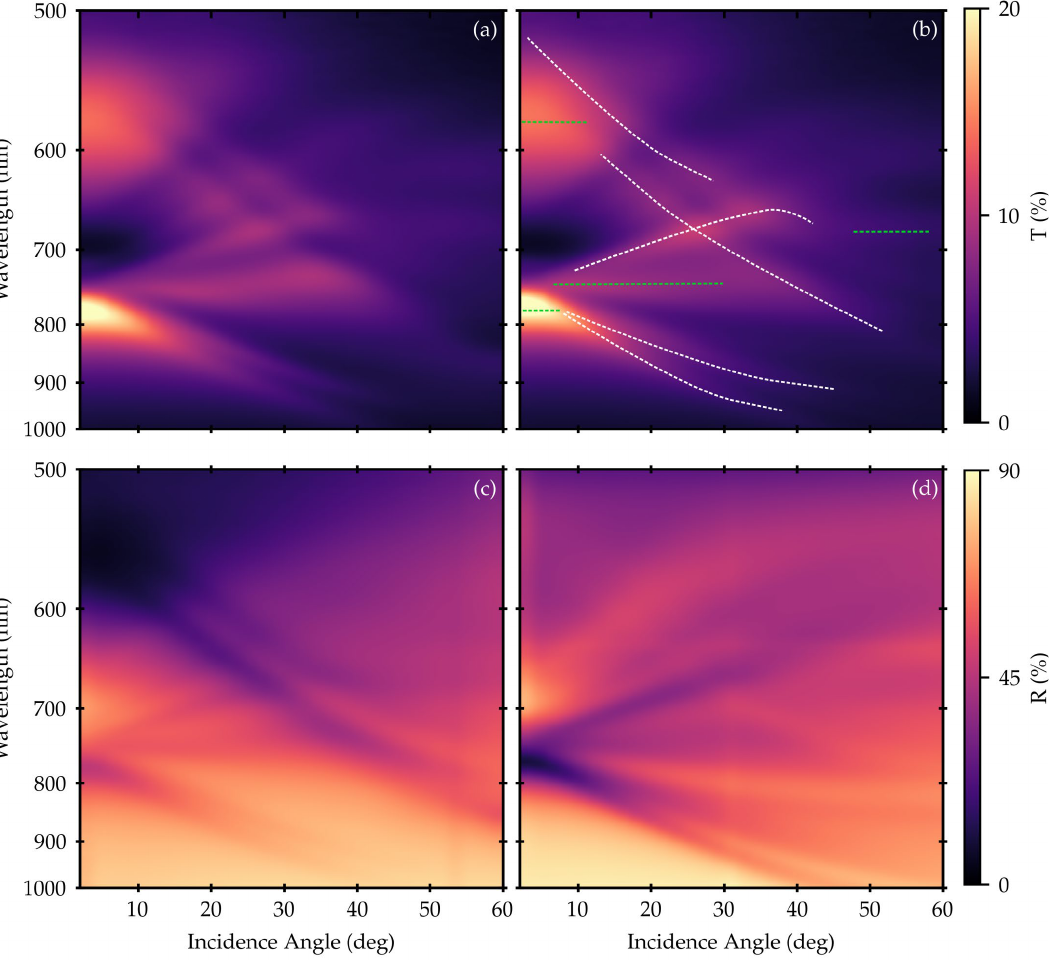
Figure 3. Bidimensional map of T ( a , b ) and R ( c , d ) of the plasmonic metasurface with respect to the incidence angle. In panels ( a , c ), the source illuminated the structure from the front side (FS), while in panels ( b , d ), this occurred from the back side (BS). In panel ( c ) the dashed lines provide an indication of the more localized (green) and more dispersive (white) nature of the complex hybrid modes resulting from the mixing of LSPs and SPPs occurring in this metasurface. A comprehensive study about the hybrid modes dispersion in such metasurfaces can be found in [43].